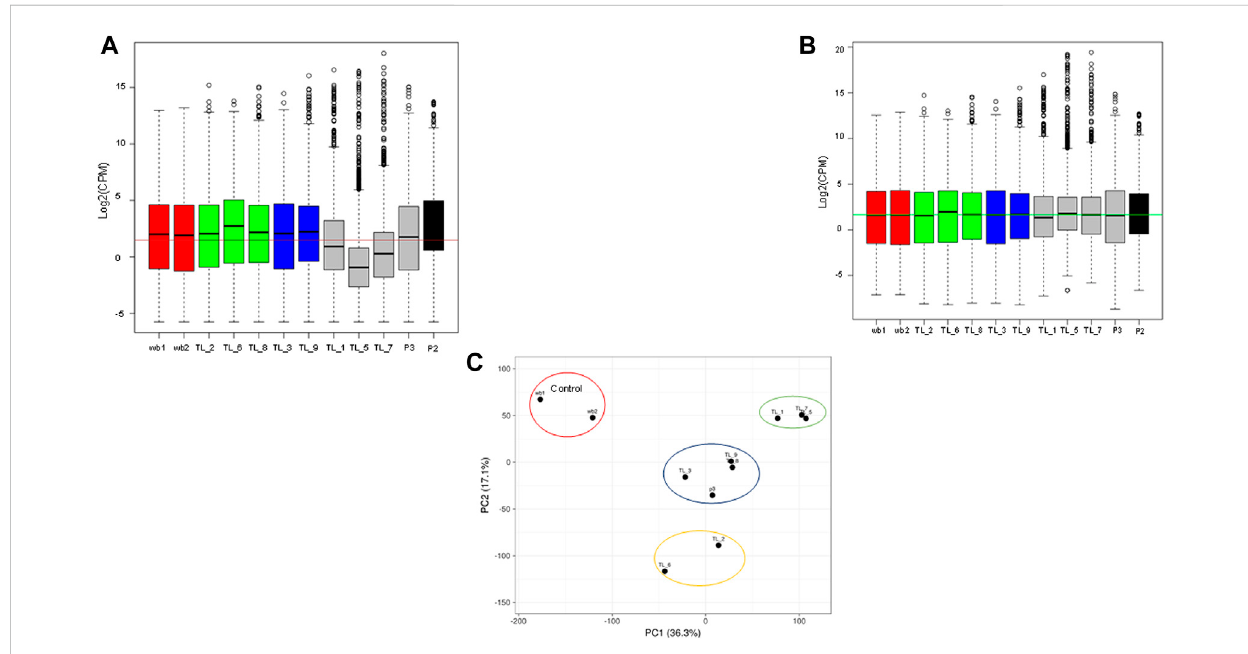
FIGURE 1 (A) Boxplot showing the raw library counts of all the samples involved in the analysis. (B) Boxplot of voom normalized libraries of all the samples. (C) PCA plot between whole blood control samples and AML samples showing three different clusters within the AML